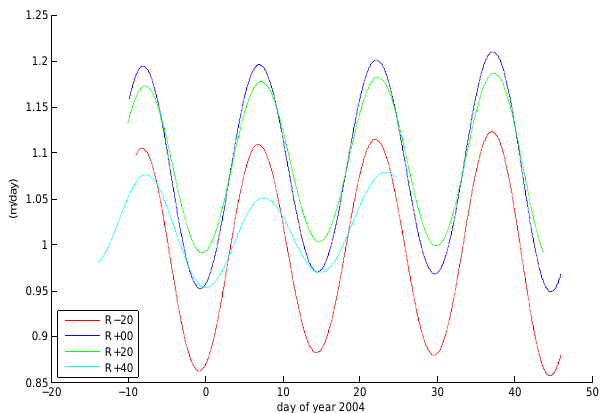
Fig. 2. Long-periodic tidal modulation in surface speeds on Rutford Ice Stream, West Antarctica. The velocities were calculated from the tidal fit to surface displacements shown in Fig. 1, including only the long-period tidal constituents.